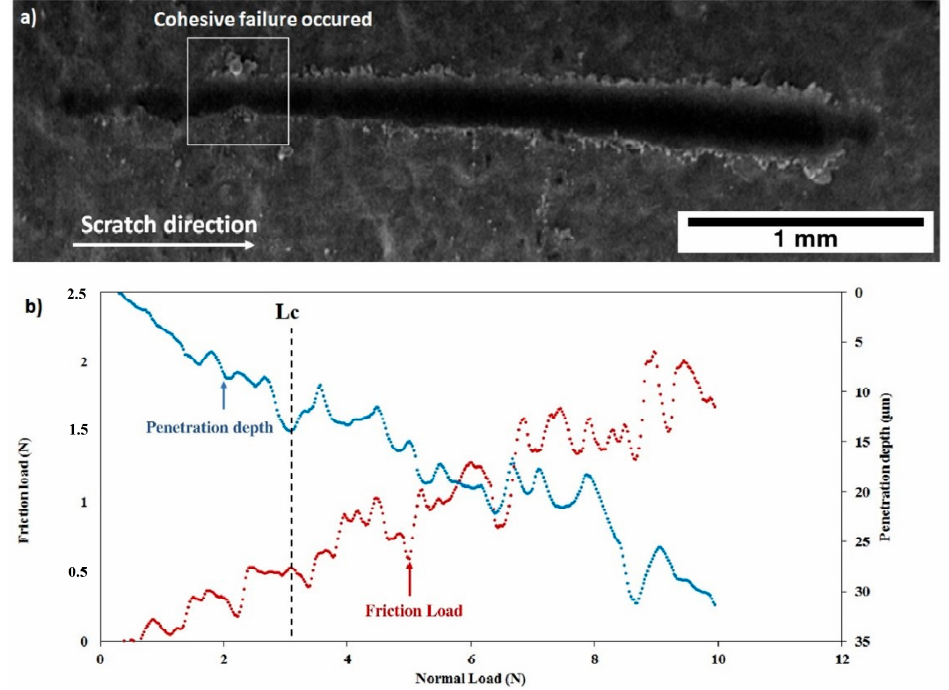
Figure 15. Scratch test of the as deposited C90 coating: ( a ) SEM micrograph of the scratch and ( b ) friction force and penetration depth as a function of normal load. Table 4. Critical loads L C calculated from the friction–load curves for both coatings C30 and C90 before and after thermal treatment.